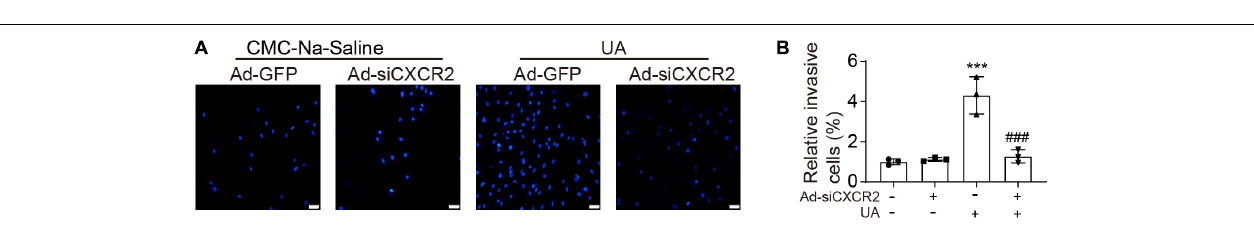
FIGURE 4 | Knockdown of CXCR2 blocked UA-induced monocyte migration in vitro. (A) Monocytes were loaded to the upper chamber, and cardiomyocytes were cultured in the lower chamber. Migrated monocytes in transwell assays were stained by 4 (cid:48) ,6-diamidino-2-phenylindole (DAPI) at 12 h after addition of CMC-Na-saline or UA to the lower chamber. (B) Quantitation of migrated cell numbers is presented in the right panel. Statistical analysis was performed by two-way ANOVA. *** P < 0.001 vs. CMC-Na-saline + Ad-GFP; ### P < 0.001 vs. UA + Ad-siCXCR2; n =